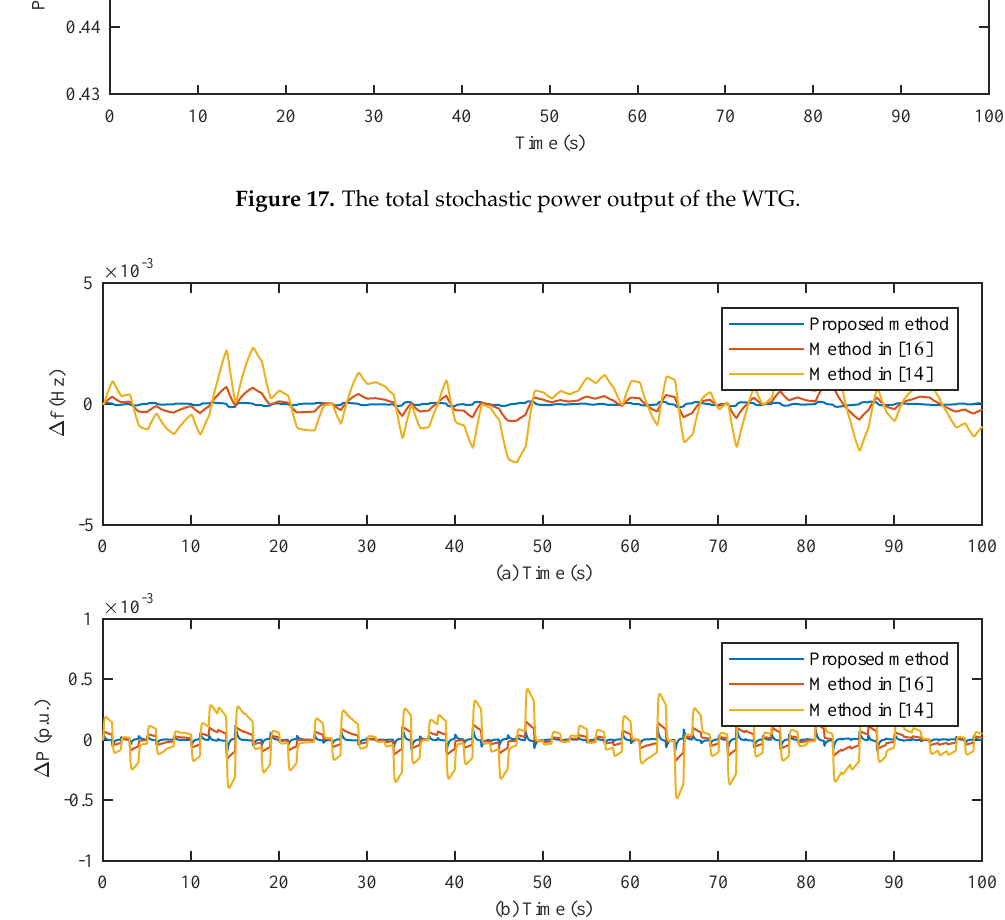
Figure 18. System transient response. ( a ) Microgrid frequency deviation. ( b ) Total power deviation.